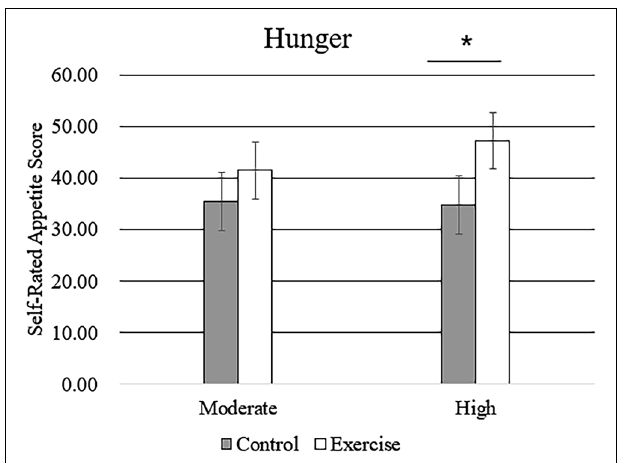
FIGURE 5 | Subjective feeling of hunger after the rest period and moderate- or high-intensity exercise. Bars represent participant means; vertical lines, standard errors of the mean; ∗ P <